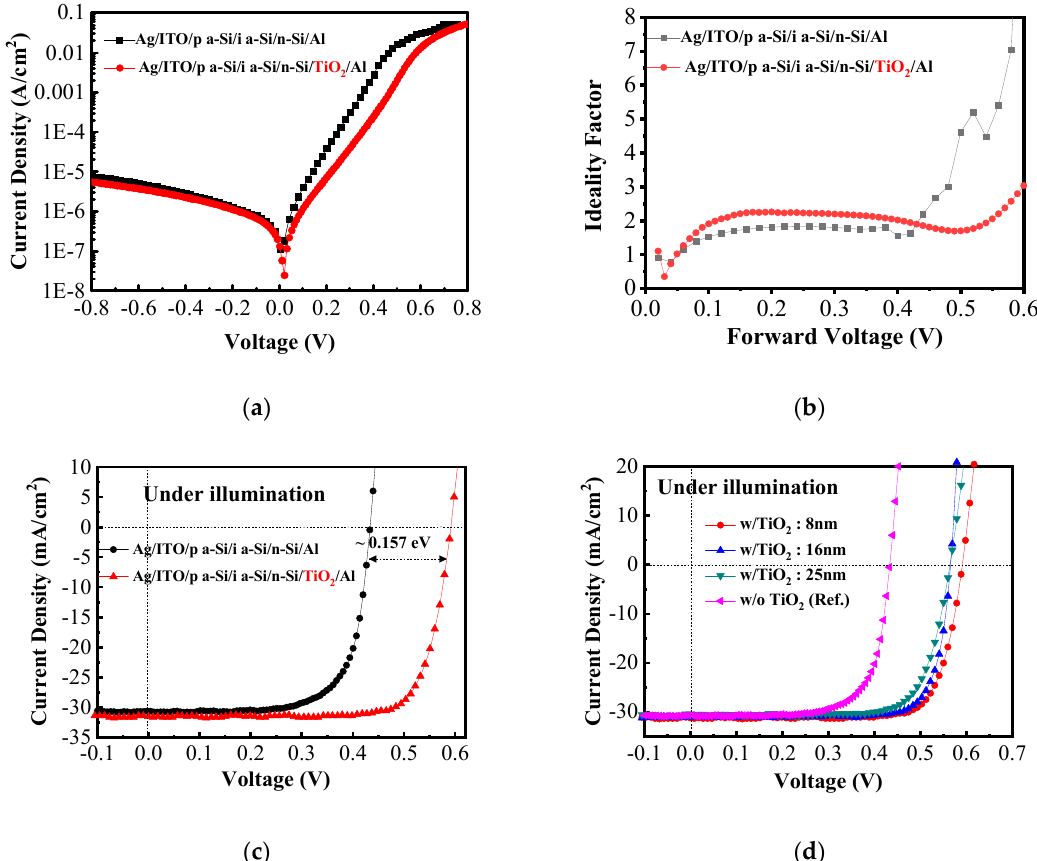
Figure 2. ( a )The diode current density-voltage characteristics for the solar cell without and with 8 nm thick TiO x rear contact layer at dark environment. ( b ) The ideality factor that calculated from the diode characteristics. ( c ) The diode current density-voltage characteristics for the solar cell without and with 8 nm thick TiO x rear contact layer under solar simulator illumination. ( d ) The diode current density-voltage characteristics for the solar cell without and with a TiO x rear contact layer of different thickness under solar simulator illumination.